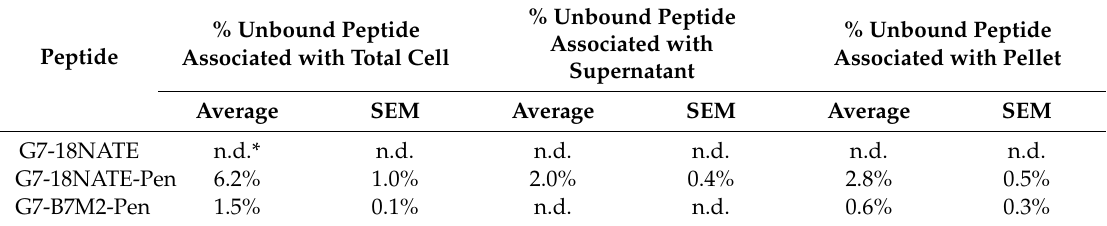
% Unbound Peptide Associated with